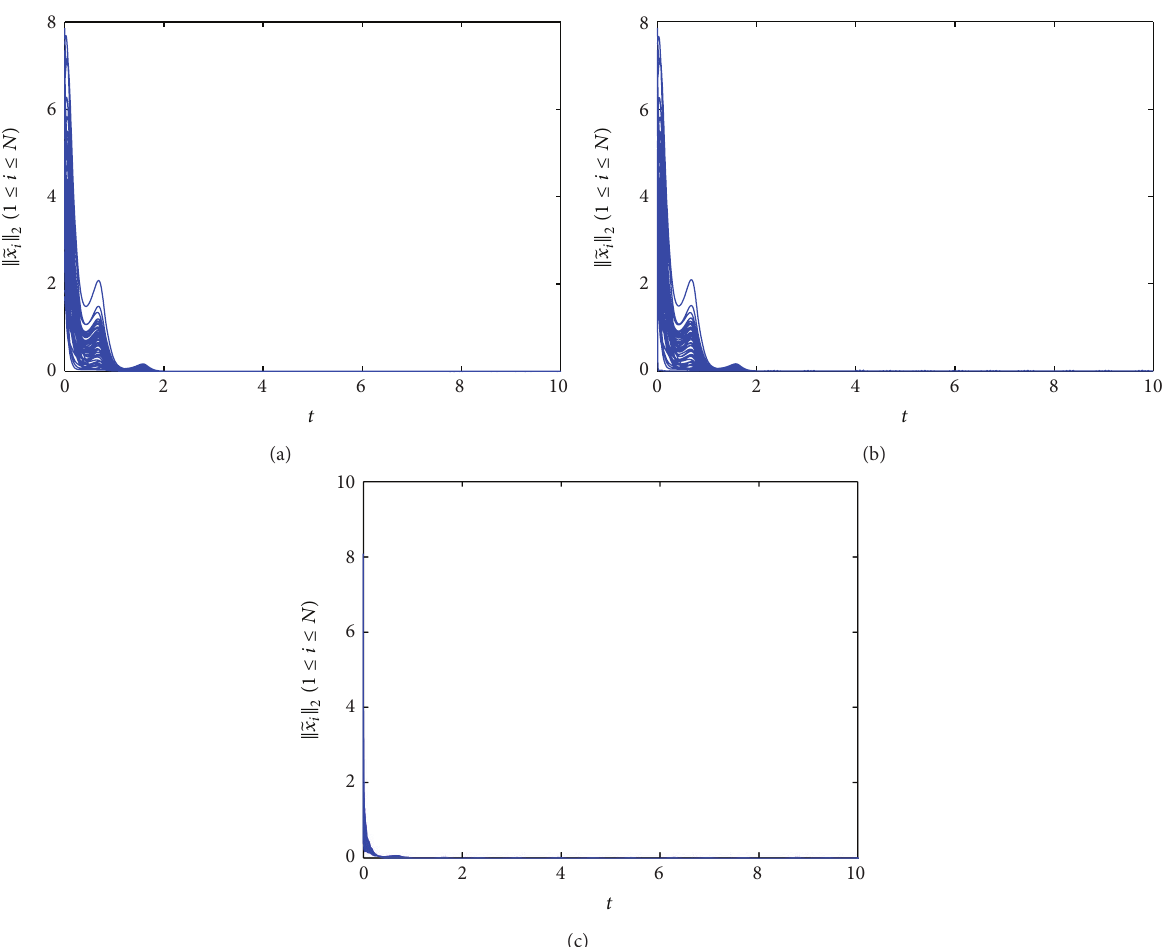
Figure 2: Synchronization errors ‖̃ x 𝑖 ‖ 2 (1 ≤ 𝑖 ≤ 50) for globally coupled network (GCN) with 𝑐 = 0.1 , H = I (a); ‖̃ x 𝑖 ‖ 2 (1 ≤ 𝑖 ≤ 50) for star network (SN) with 𝑐 = 5 , H = I (b); ‖̃ x 𝑖 ‖ 2 (1 ≤ 𝑖 ≤ 50) for loop network (LN) with 𝑐 = 310 , H = I (c). outer-coupling matrix nearest 0 can be used for judging synchronizability of